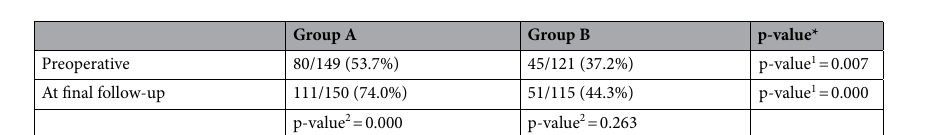
Table 4. Rates of fusion for Worth 4-dot test in groups A and B. Group A = alignment between 10 prism dioptres (PD) exodeviation and 5 PD esodeviation at the last follow-up; Group B = residual or recurrent exotropia defined as exodeviation > 10 PD at last follow-up. p-value 1 : Comparison between group A and group